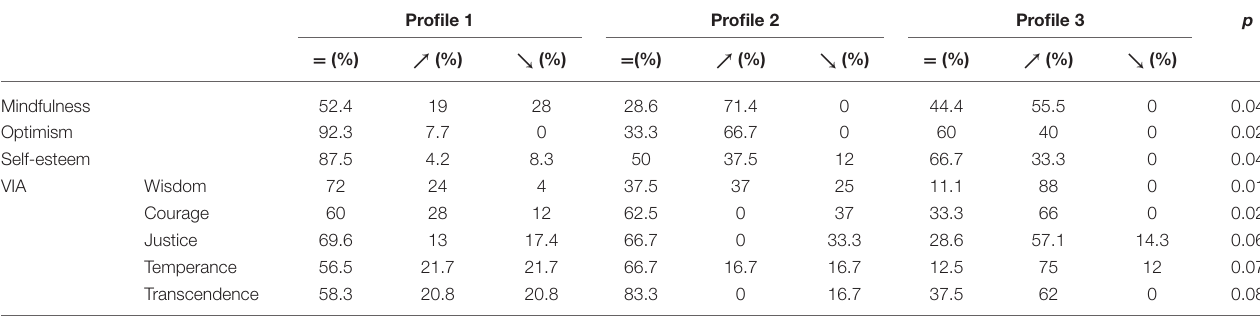
TABLE 4 | Percentage of subjects in each profile for the psychological resources with significant changes at the post-HRT compared to the pre-HRT